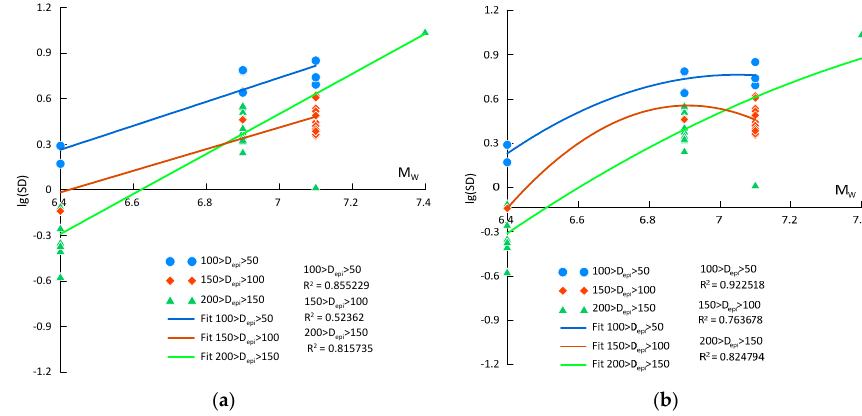
Figure 5. Spectral displacement as a function of moment magnitude for T = 1.0 s, ground type C, moderate-large national records 1977, 1986, 1990. ( a ) Linear dependence; ( b ) Quadratic dependence of logarithm of spectral displacement with magnitude.